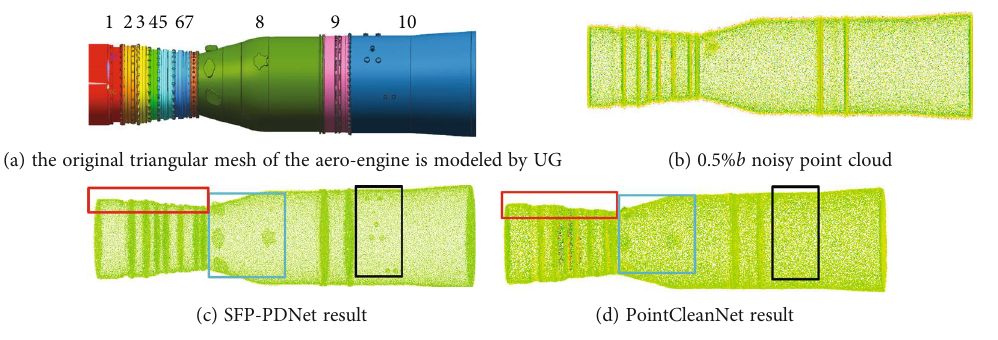
Figure 27: Qualitative comparison between SFP-PDNet and PointCleanNet on multistage assembly of aero-engine casings.